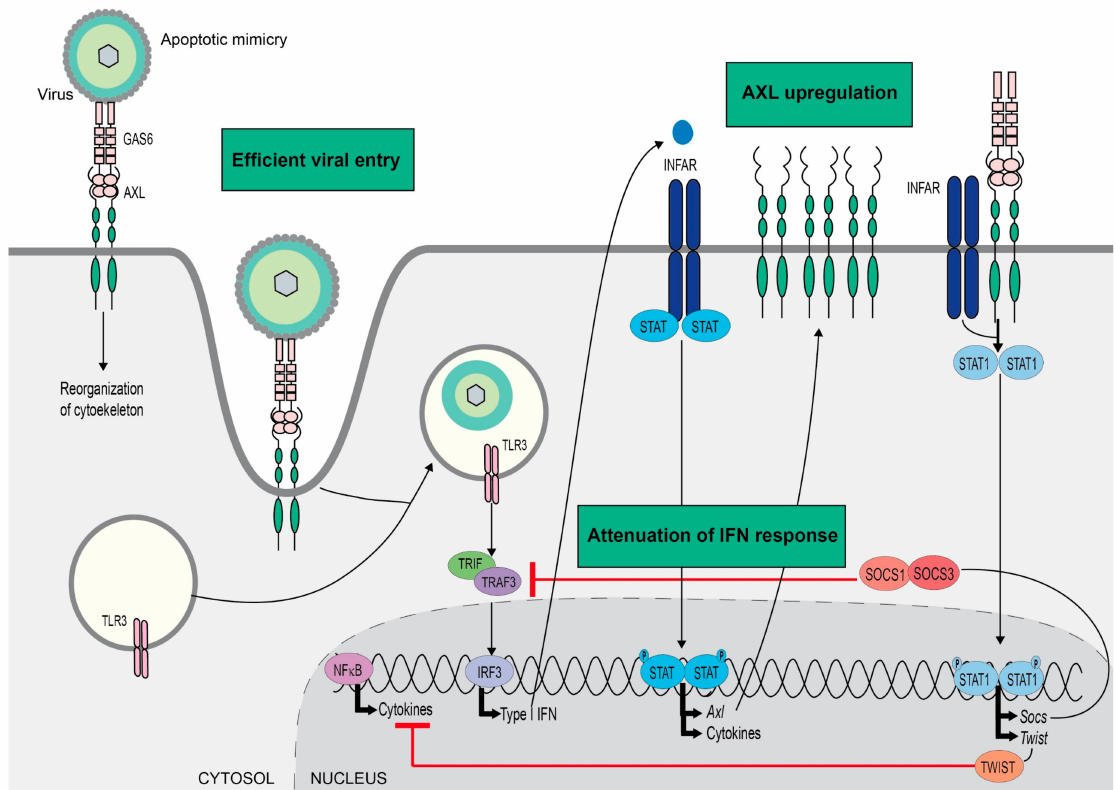
Figure 2. AXL implication in viral infection. Specific viruses take advantage of TAM role in e ff erocytosis bridging viral envelope phosphatidylserine (PtdSer) to target cells, a strategy named apoptotic mimicry. AXL intracellular signaling induces reorganization of cytoskeleton and promotes engulfment of virus increasing infectivity. Further, toll like receptor (TLR) stimulation by viral particle and the consequent type I interferon (IFN) antiviral response upregulate AXL